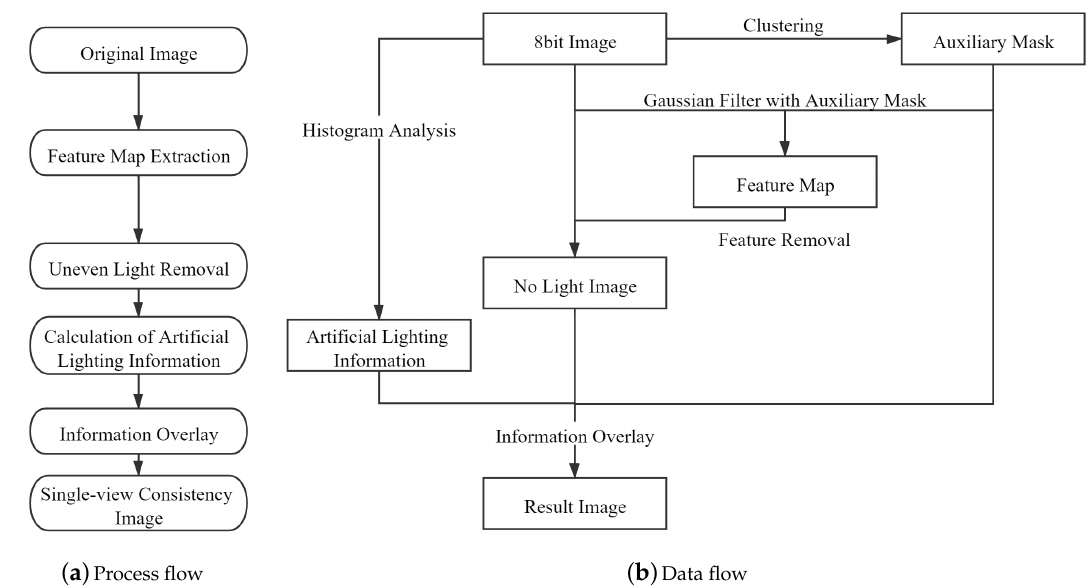
Figure 5. The process of single-view color consistency processing. ( a ) The process flow. ( b ) The data flow according to the process